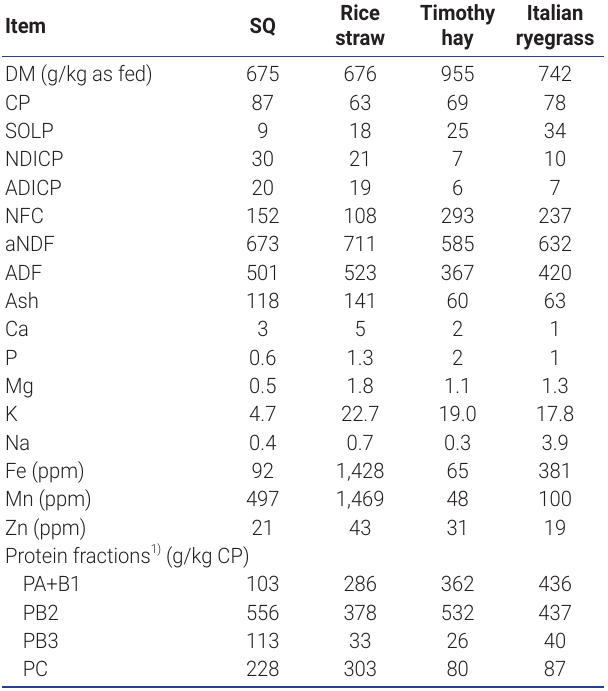
Table 1. Chemical composition of feeds used in in vitro and in